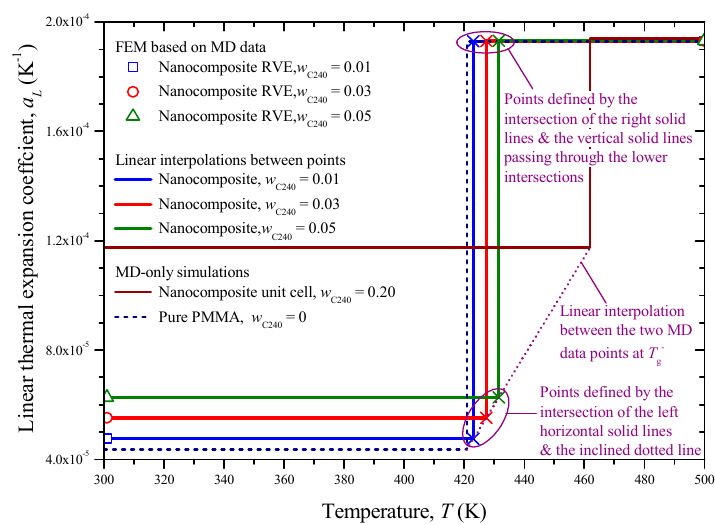
Figure 14. Linear thermal expansion coefficient of the nanocomposite with small fullerene mass fractions with respect to the temperature, predicted by combining FEM and MD as well as using linear interpolations.